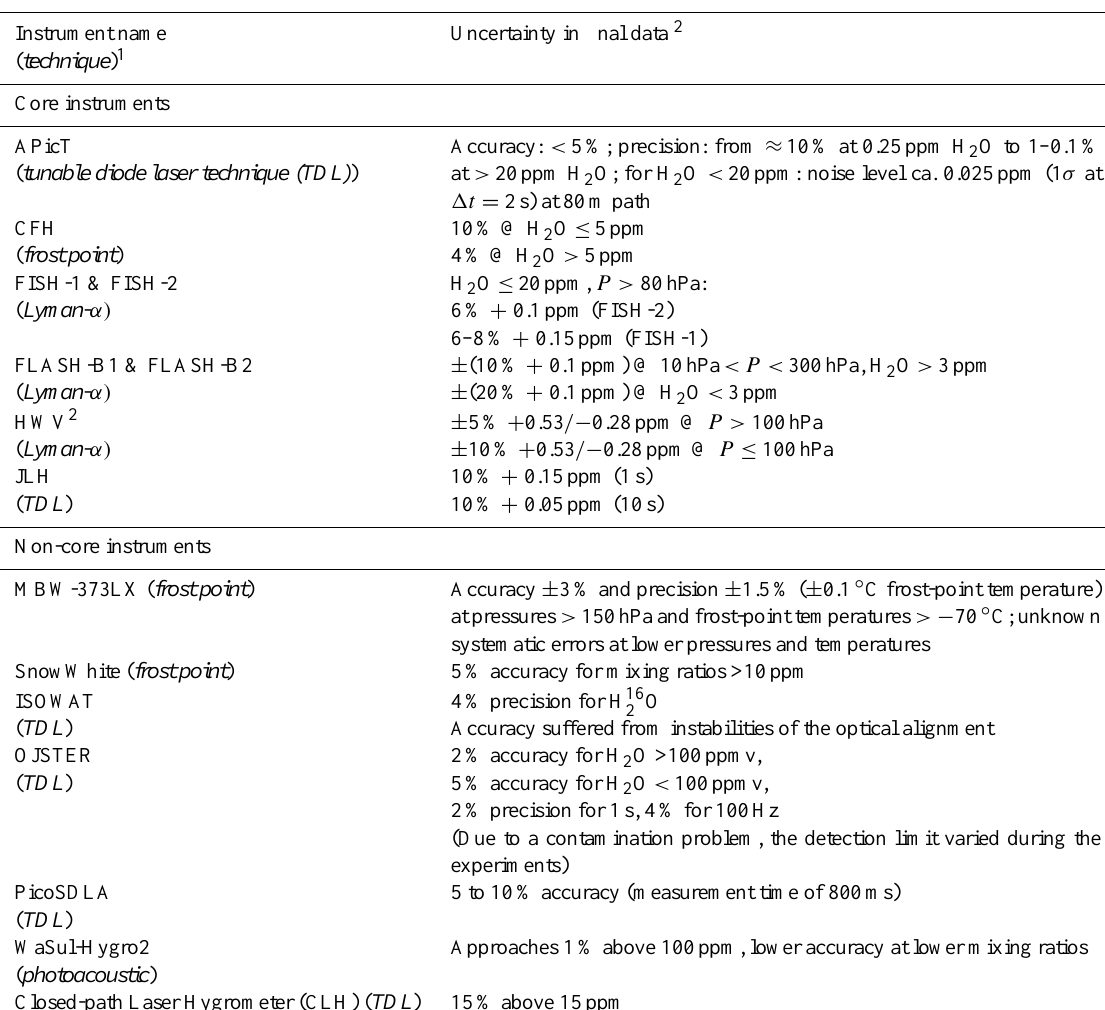
Table 2. Core and non-core instrument uncertainty